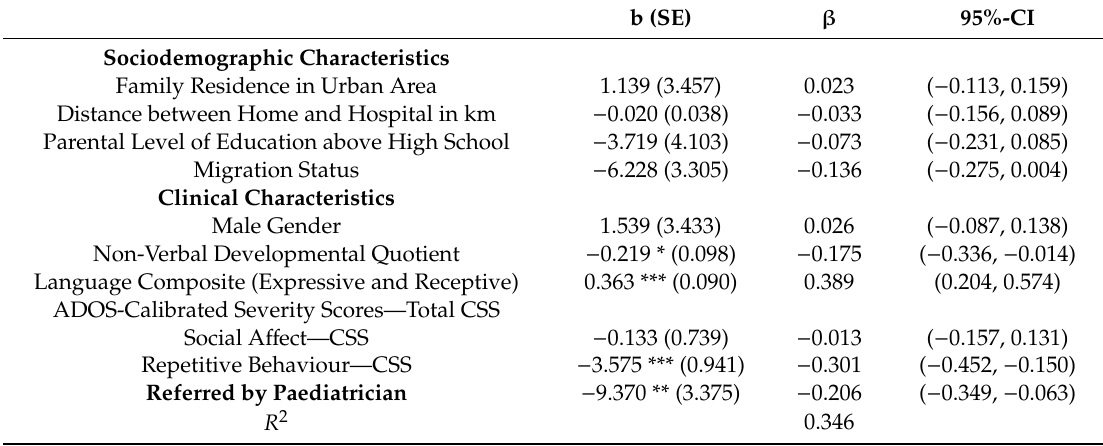
Table 4. Regression model for age at